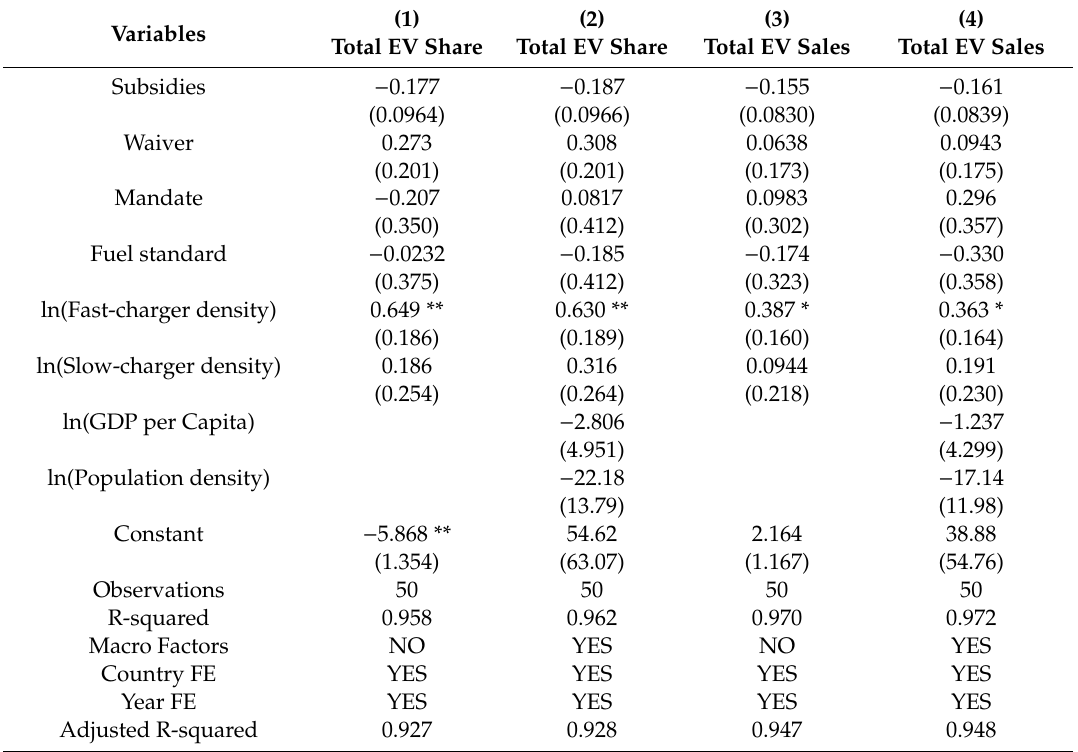
Table 8. Policy impact on total EV